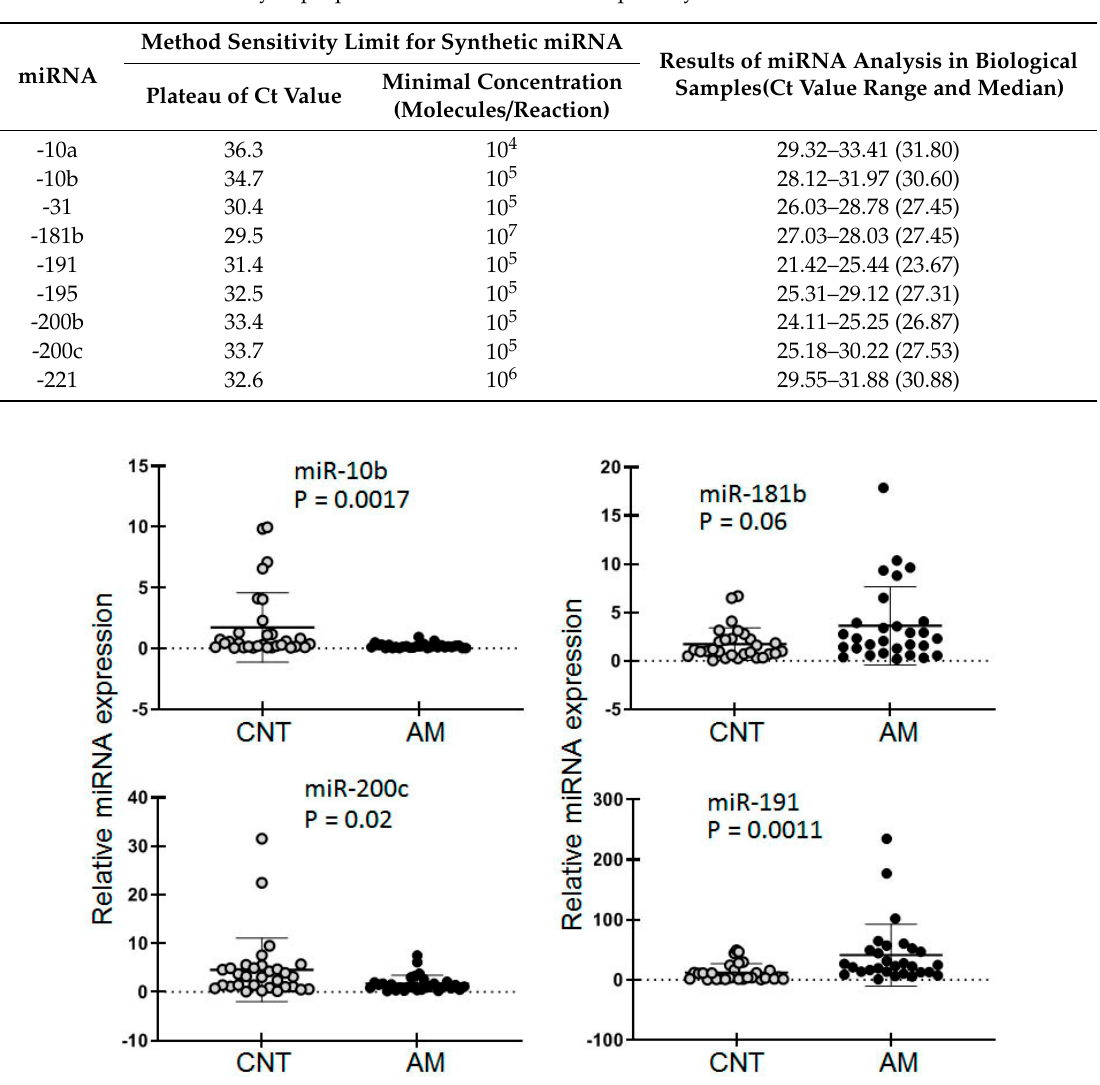
Figure 4. The expression of selected miRNAs in the eutopic endometrium of healthy women (CNT, n = 33) and women with adenomyosis (AM, n = 30) tested by tt-RT-PCR systems. The results were normalized to the U6 snRNA and the relative expression data were grouped (CNT and AM). The